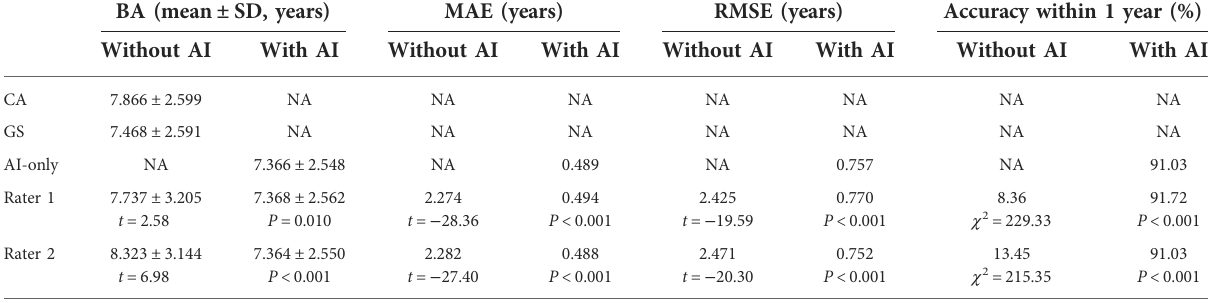
TABLE 2 Accuracy of BA assessment from different raters and effect of AI on raters ’ performance. BA (mean ± SD, years)